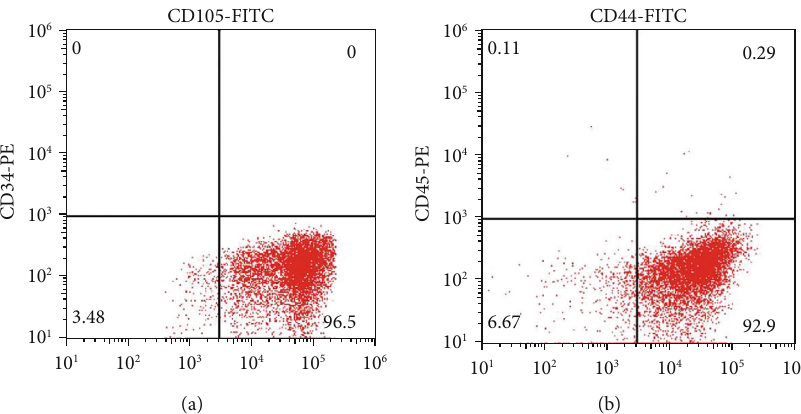
Figure 2: Surface marker pro fi les of isolated and cultured BMSCs. The percentages of CD105+/CD34 (a) and CD44+/CD45 (b) cells were 96.5% and 92.9%,